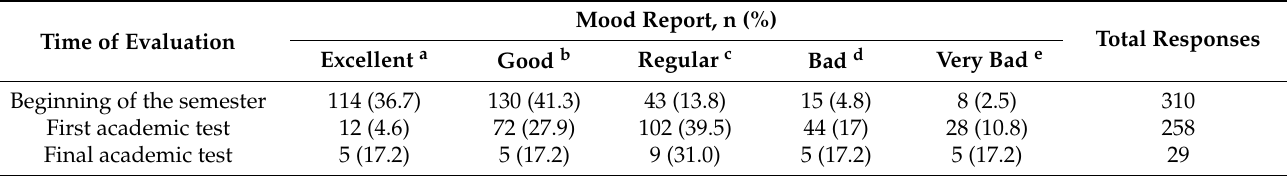
Table 3. Comparisons of mood between different school periods.